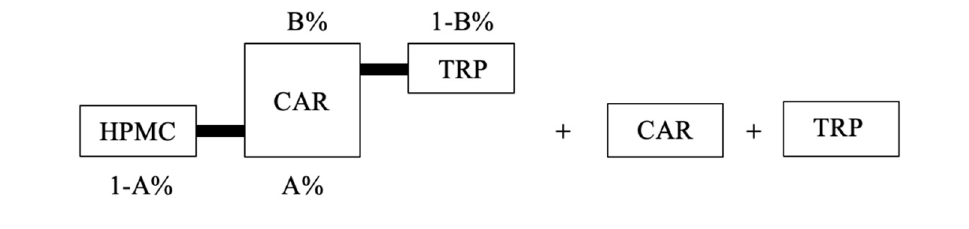
Figure 4. Schematic representation of phases in A − B + C ternary system.